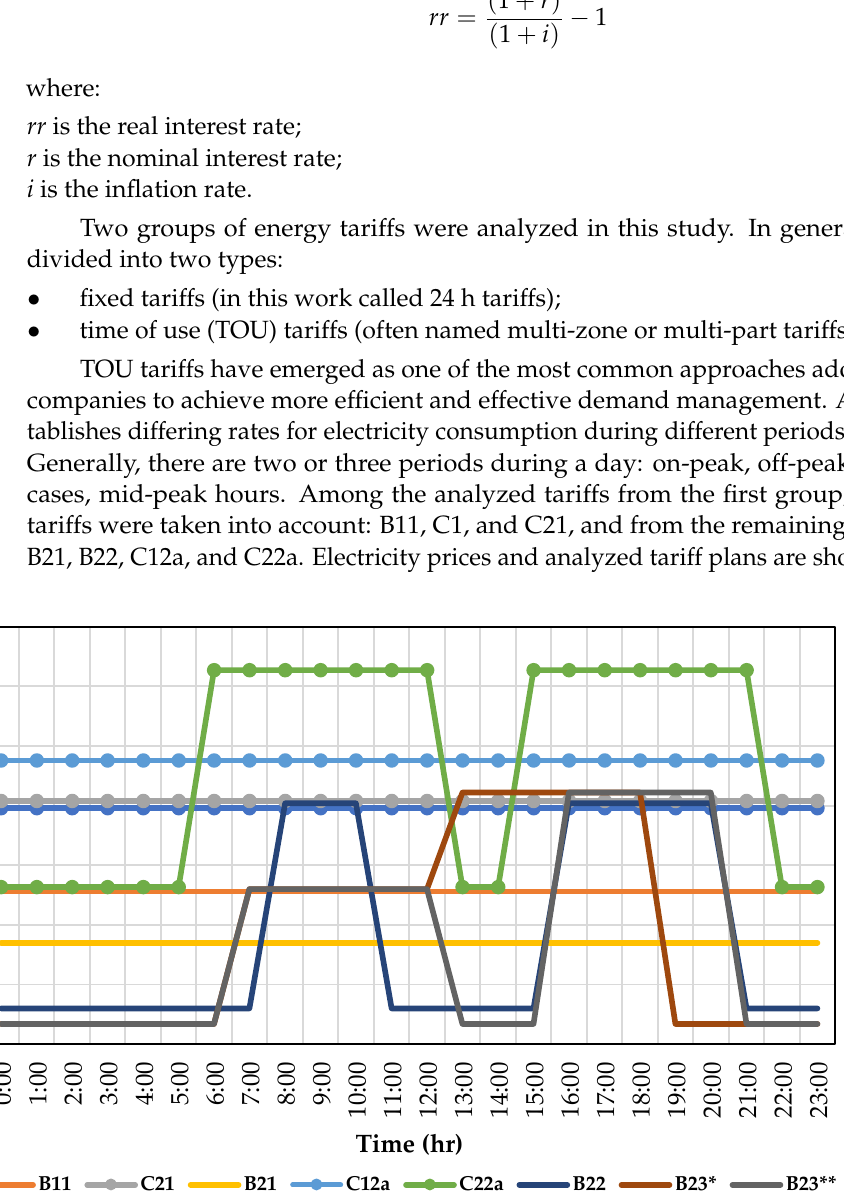
Figure 3. Electricity prices in analyzed tariff plans (1PLN~ 0,22 € ). B23* and B23** indicate the tariff plan for spring and fall - winter.